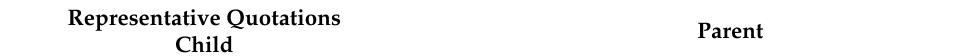
Table 5. Aversive responses to sugary drink cessation reported during qualitative interviews with participants and their parents; n = 30